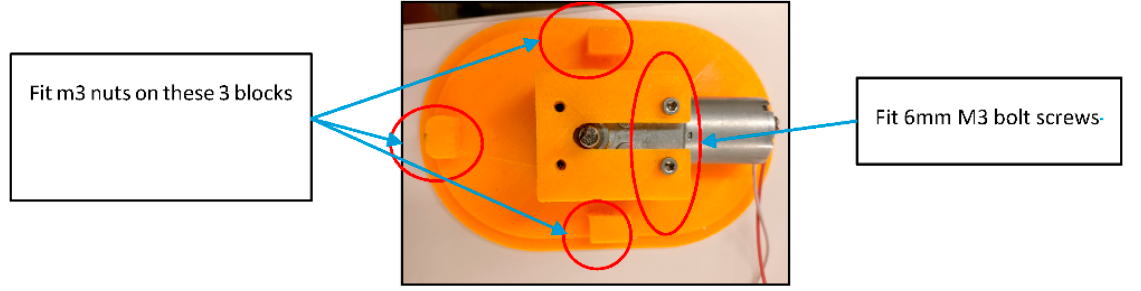
Figure 9. Base assembly.